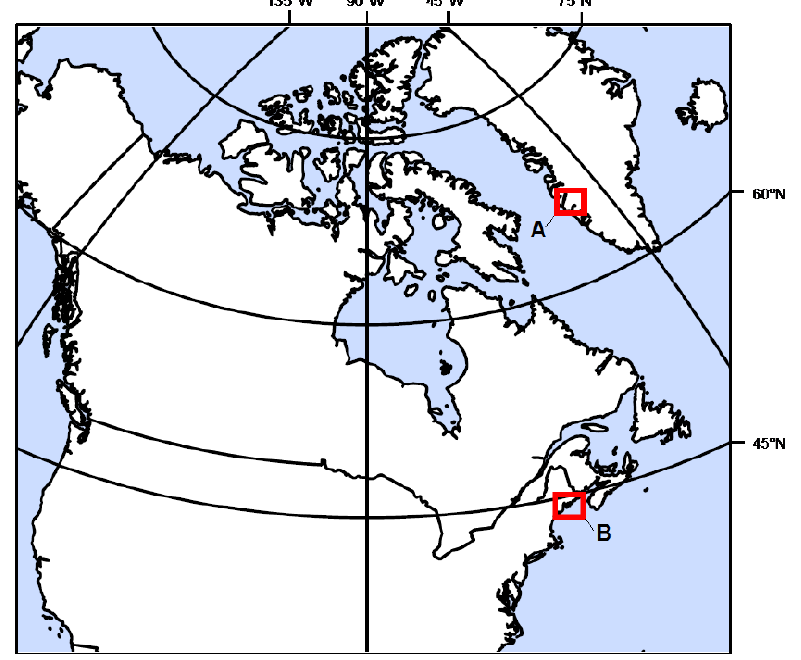
Figure 2. Map depicting the location of the ( A ) Arctic and ( B ) boreal study sites.